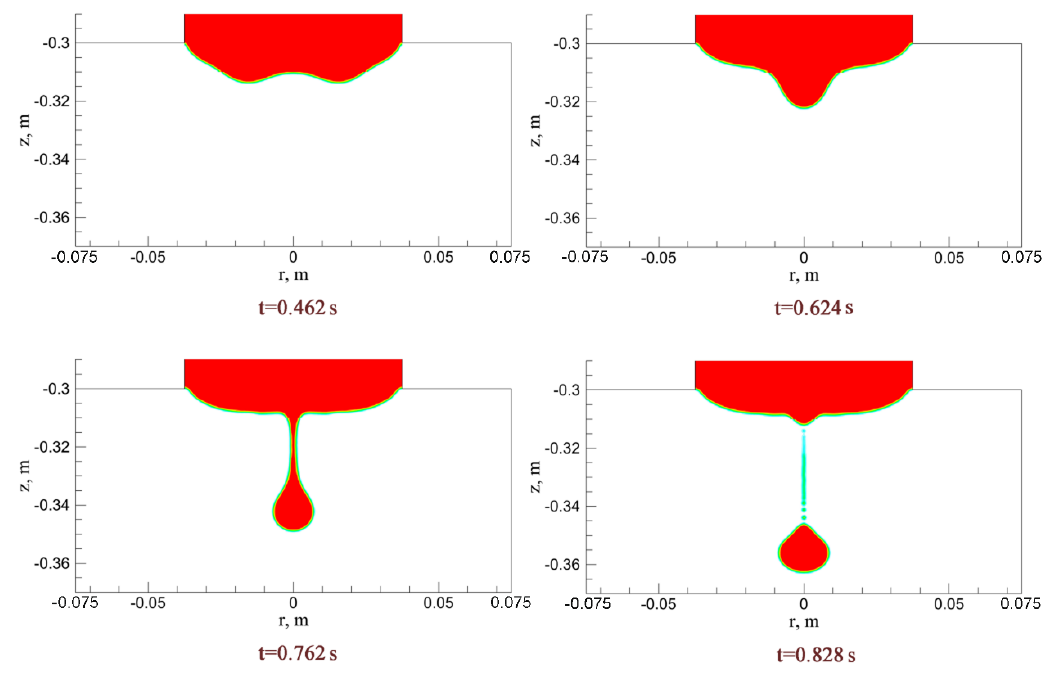
Figure 11. Formation and dripping process of droplet of OE-ESR.